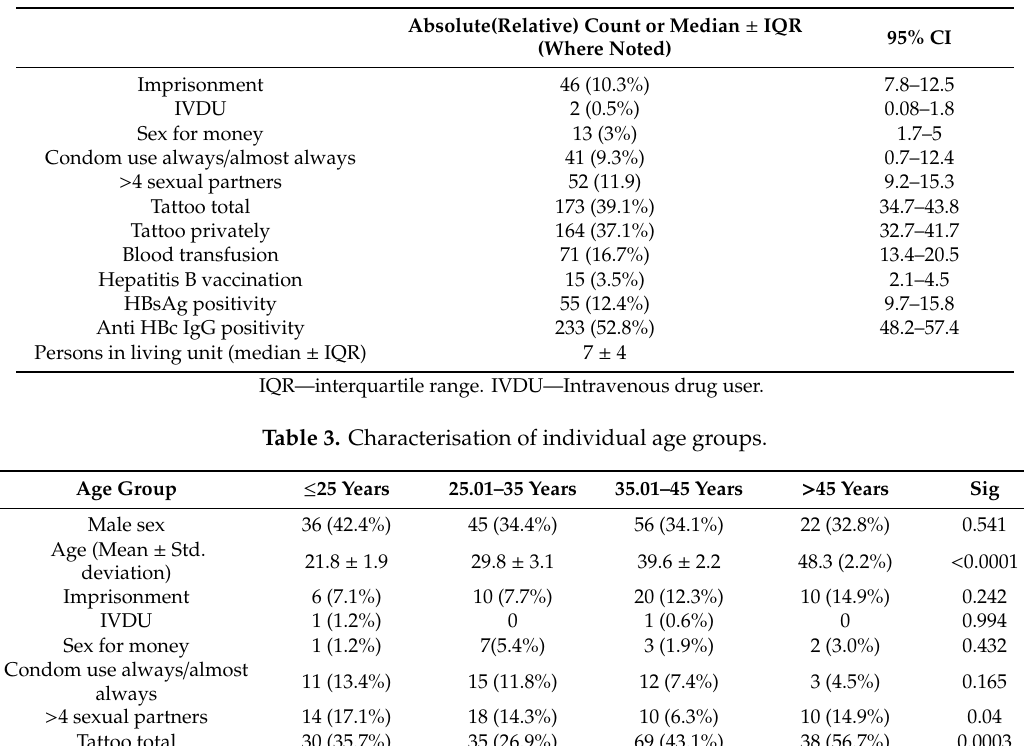
Table 2. Description of the whole cohort.